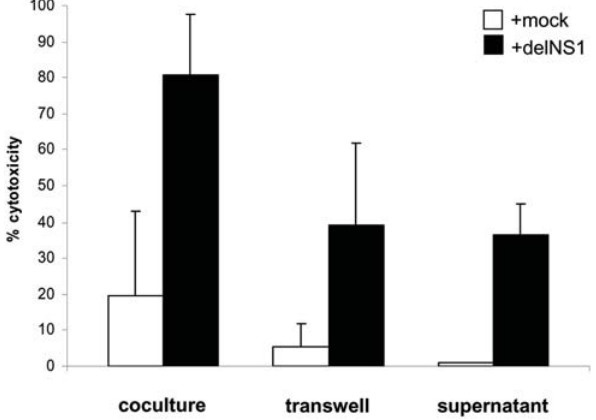
Figure 5. Effect of mock-treated or infected PBMCs on tumor cells under different co-culture conditions. PBMCs were infected with delNS1 virus (m.o.i.=0.02) or mock-treated and incubated for 24 hours. Then the PBMCs were either co-cultured directly with the target A375 cells (co-culture) or were kept without cellular contact to target cells (transwell). Alternatively, target cells were only supplied with the 24 hour supernatant of PBMC cultures (supernatant). The effector to target ratio was 25:1. After 24 hours cytotoxicity was assessed. Mean results ( 6 SD) in percentage of cytotoxicity are shown from three independent experiments, each performed with PBMCs derived from a different donor.